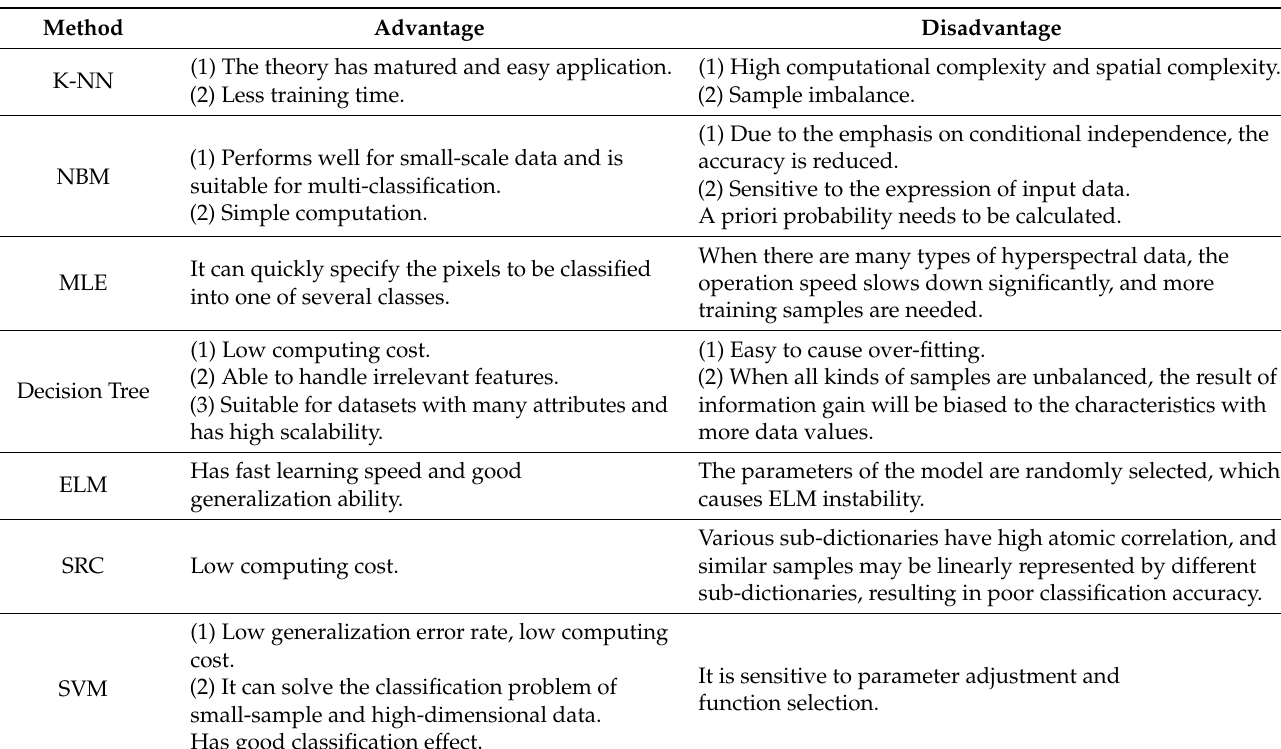
Table 2. Comparison of supervised learning